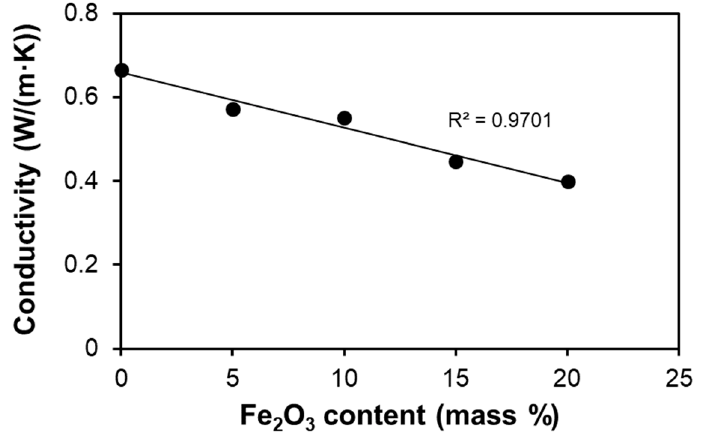
Figure 5. Thermal conductivity dependence with iron (III) oxide content of the lime mortar.